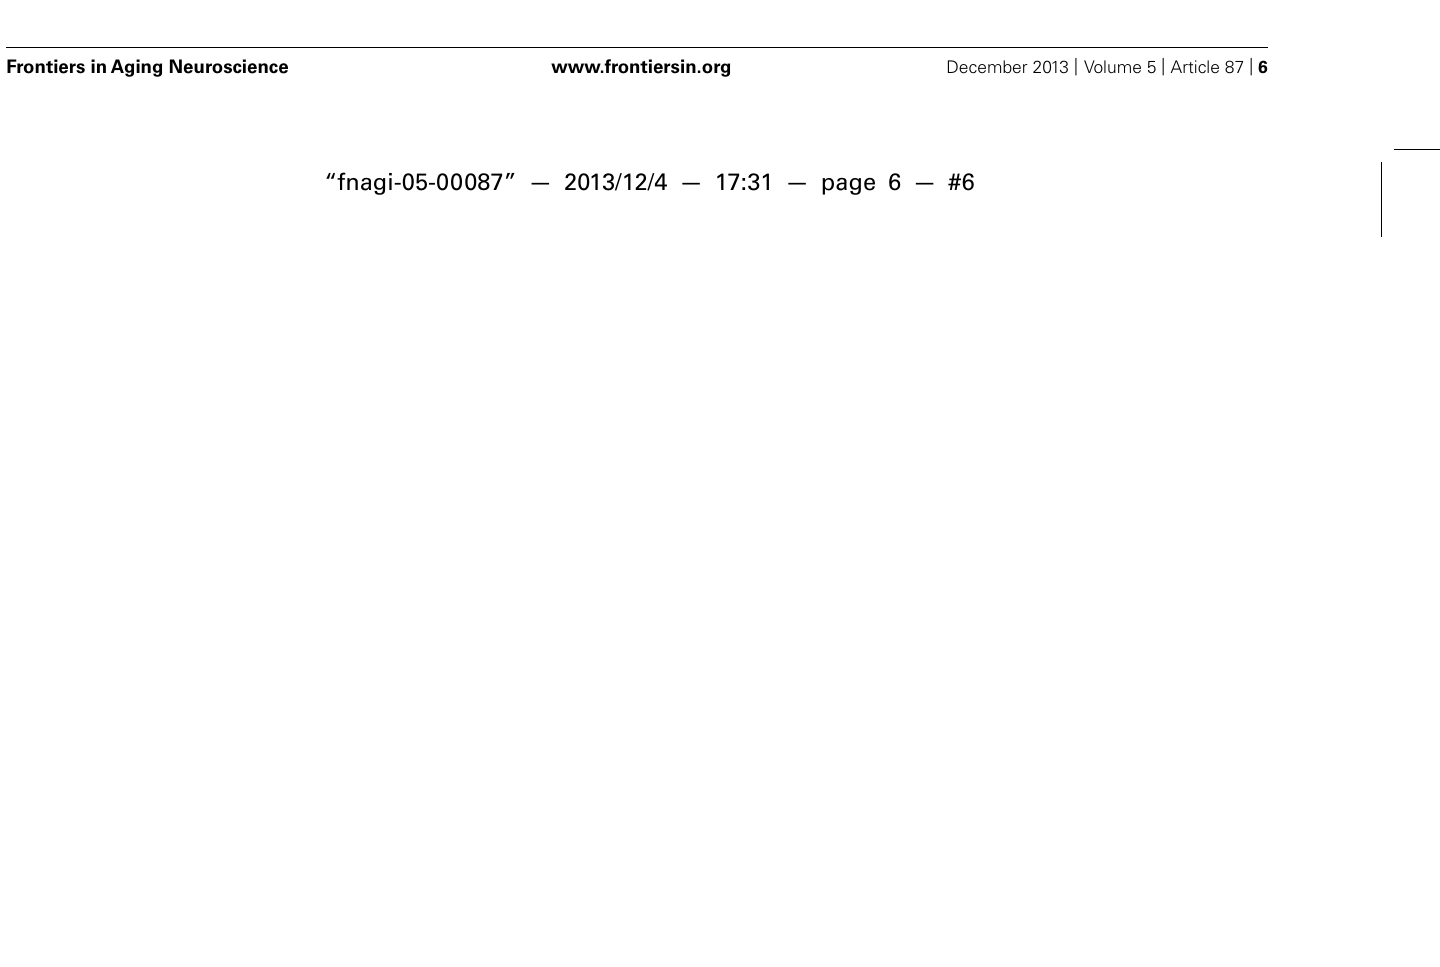
30 min. No differences in the indices of plasticity or motor perfor- mance were observed between unilateral and bilateral